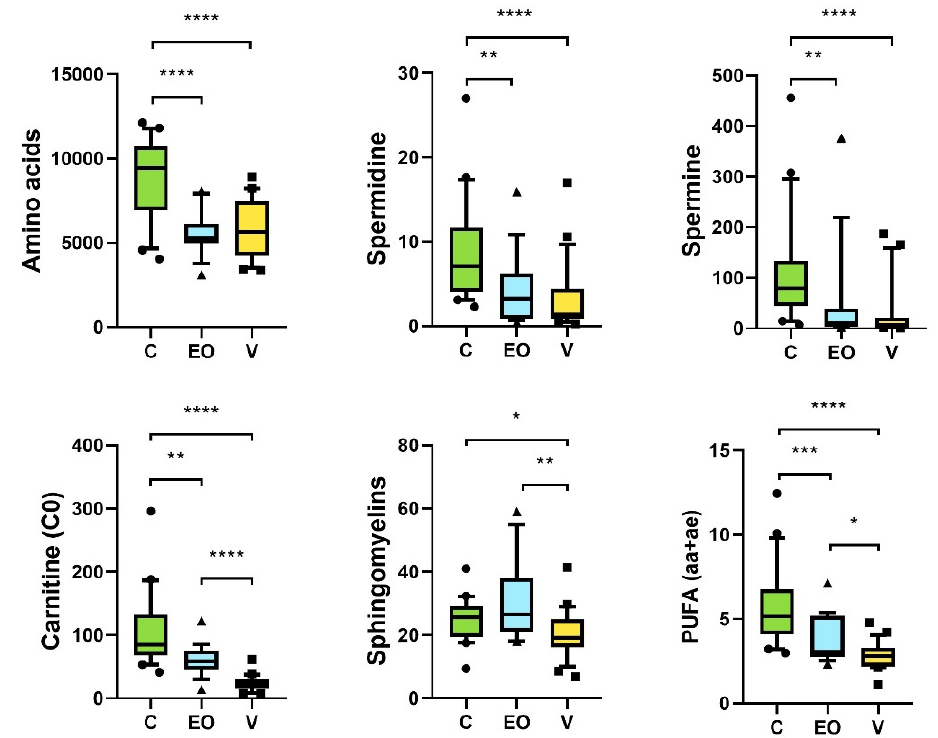
Figure 4. Box plot of the relevant sums in the three groups of patients. The boxes are delimited by the 10th and 90th percentile. The line drawn inside the box represents the median value. The lines on either side of the boxes represent the variation in the data and the individual points (dots, squares, or triangles) represent outliers. Y axis represents the concentration of each metabolite in µ M. p -values were obtained using the non-parametric Mann–Whitney test. *: significant p -value < 0.05; ** significant p -value < 0.01; *** significant p -value < 0.001and **** significant p -value <